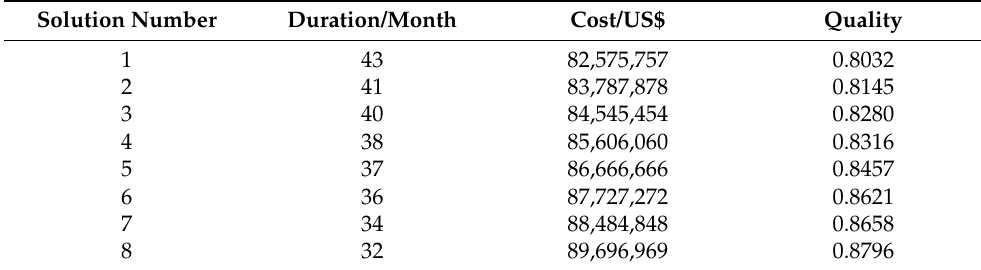
Table 5. Optimization result data of concrete-face rockfill dam